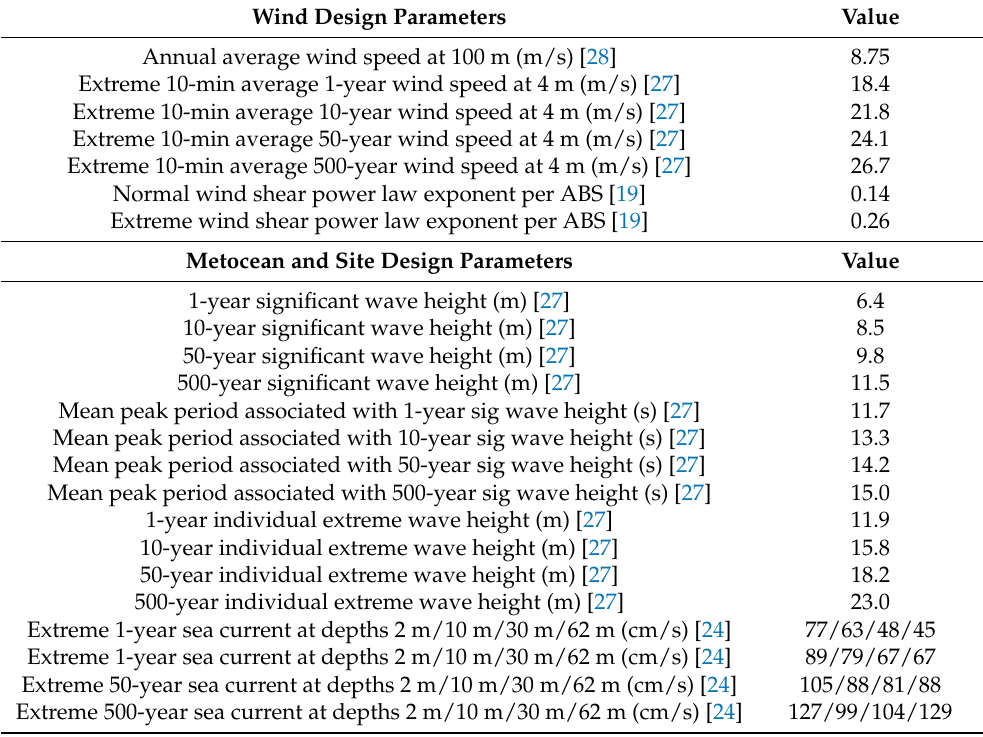
Table 16. Summary of environmental design parameters. Wind Design